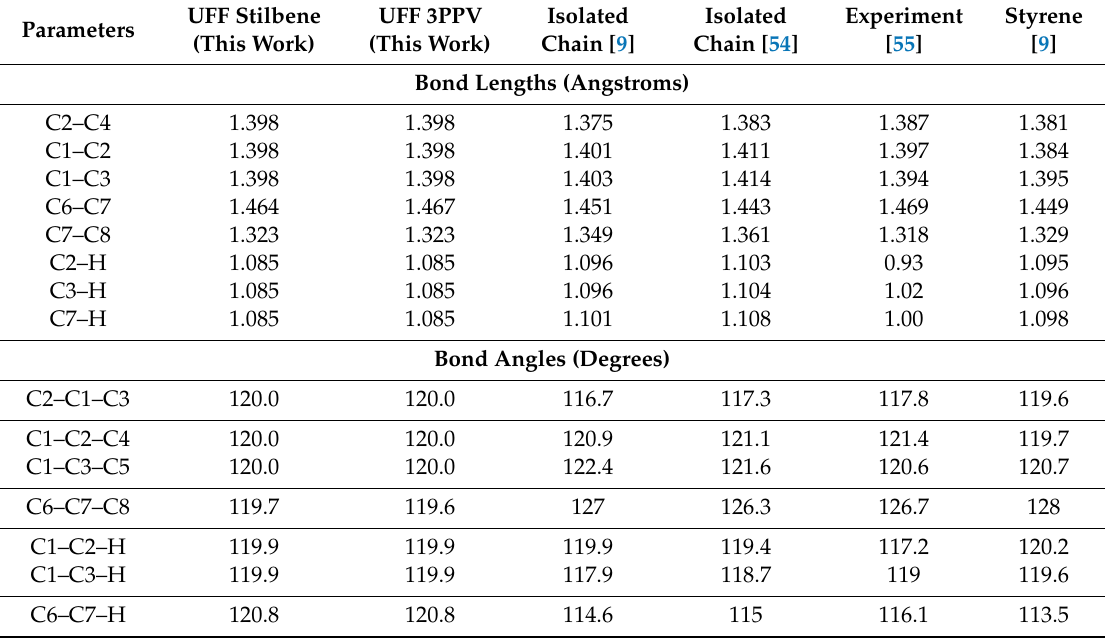
Table 2. A comparison of PPV geometry optimization obtained in this study and cited works. Parameters